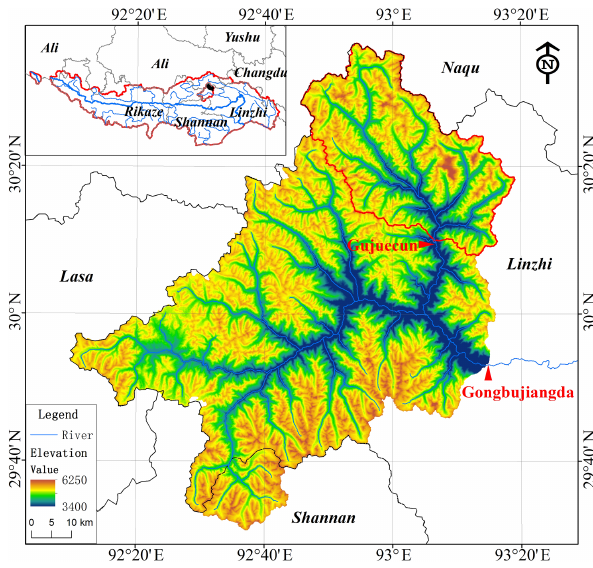
Figure 2. Map of the study area (1. Yarlung Zangbo, 2. Gongbu- jiangda, 3. Gujuecun